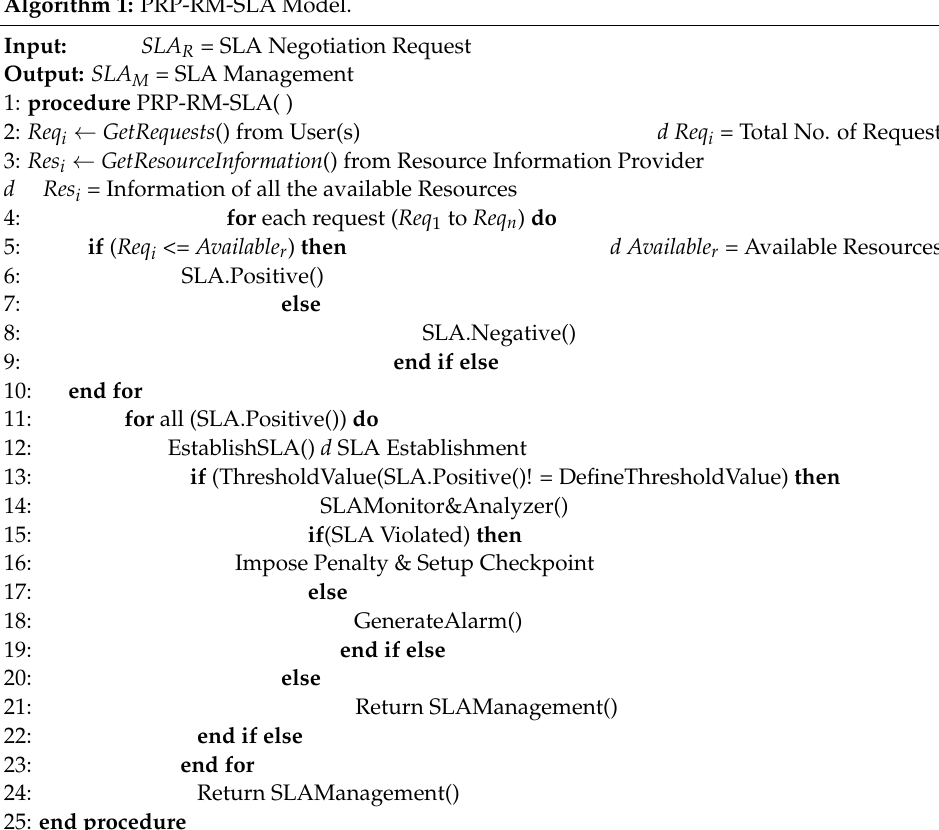
Algorithm 1: PRP-RM-SLA